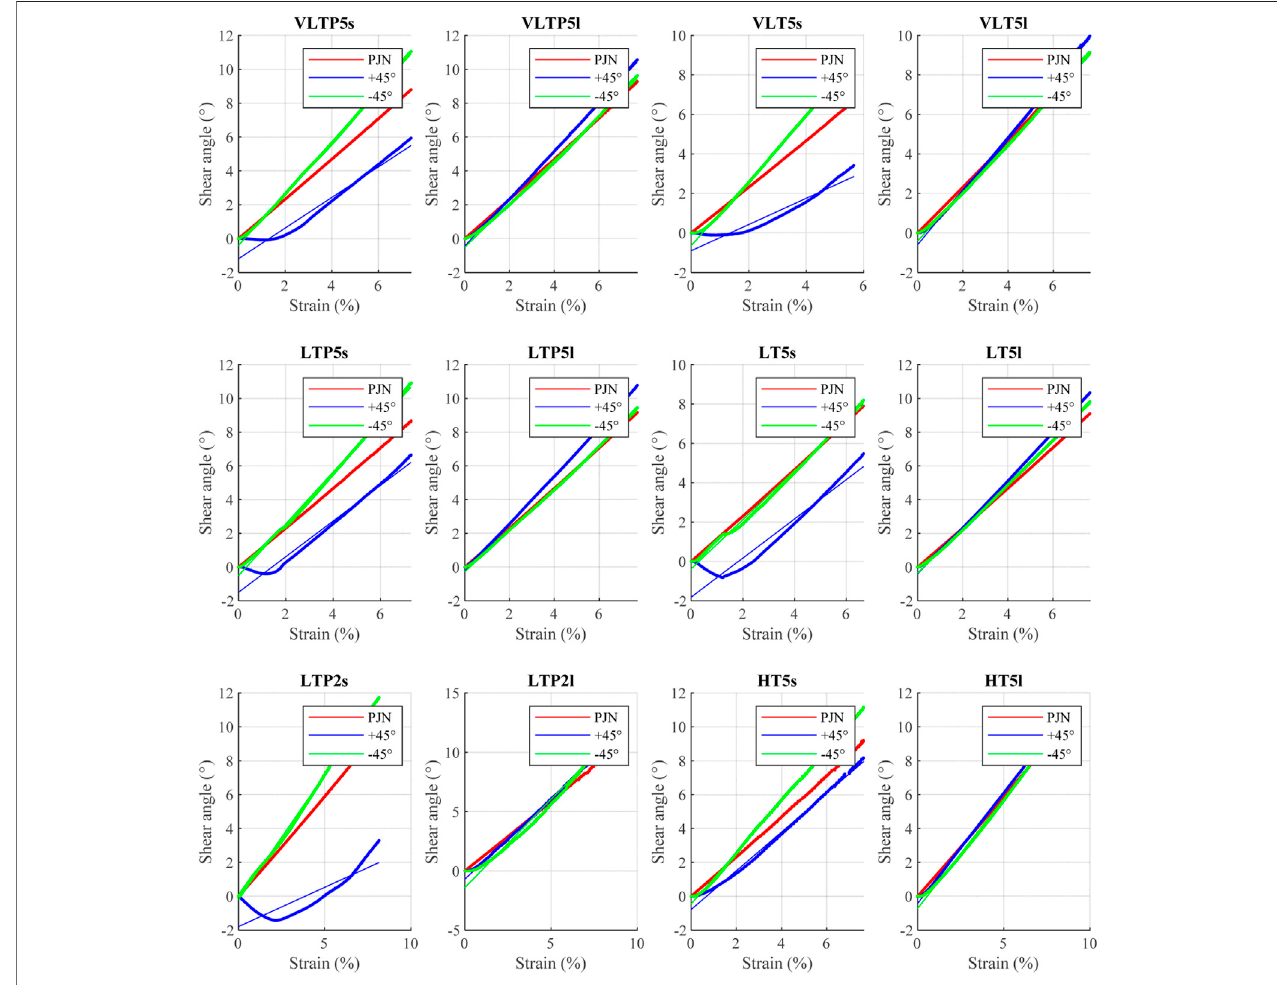
FIGURE 6 | Shear vs strain plots for six NCF formats compared to PJN model, stitch and loop side, 45 and − 45 fi bre shear directions shown.